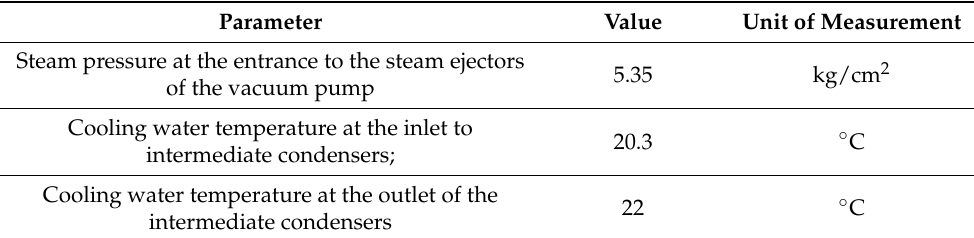
Table 9. Parameters of material streams of the vacuum overhead system.